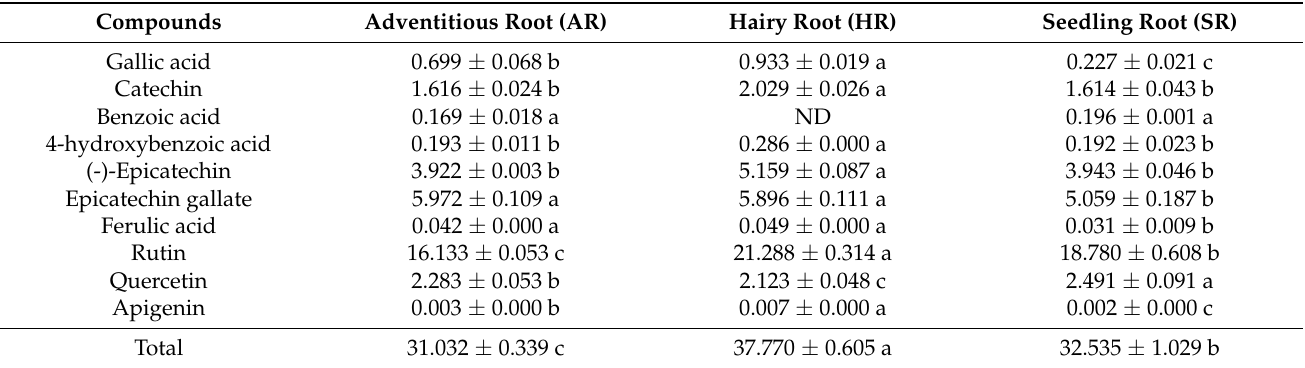
Table 2. Phenolic contents ( µ g/g DW) of the adventitious root (AR), hairy root (HR), and seedling root (SR) of F. tataricum